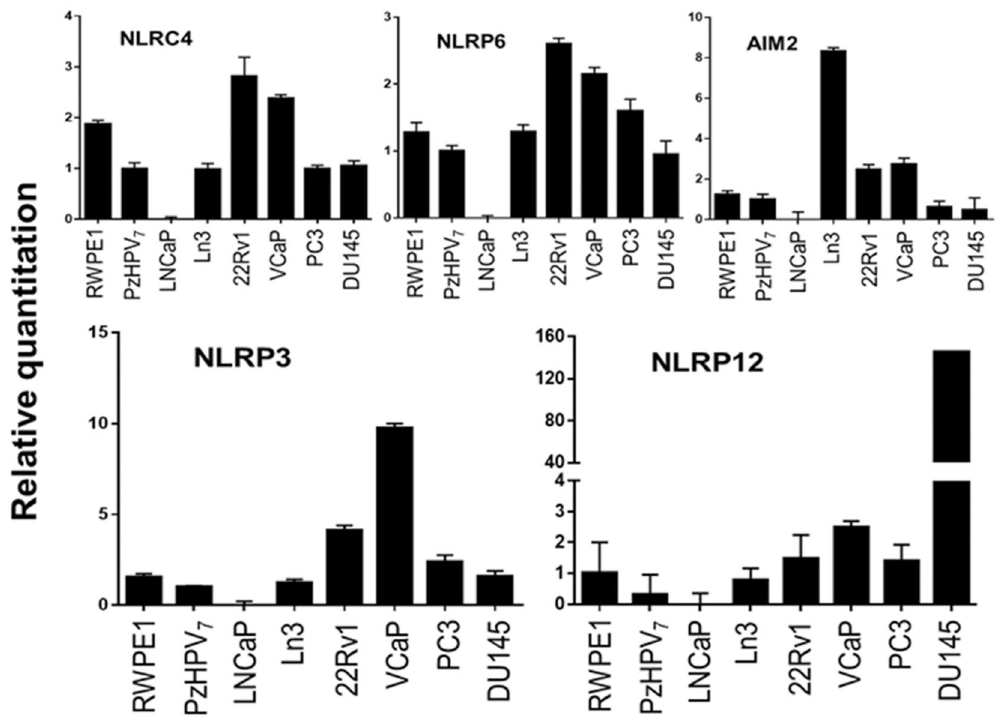
Figure 2. The mRNA expression levels of various NLR receptors (AIM2, NLRP3, NLRC4, NLRC6, and NLRP12) of the inflammasome complex in a panel of human prostate cancer cell lines. The mRNA level was analyzed using quantitative PCR using GAPDH as internal control. The experiment was repeated multiple times from different cell